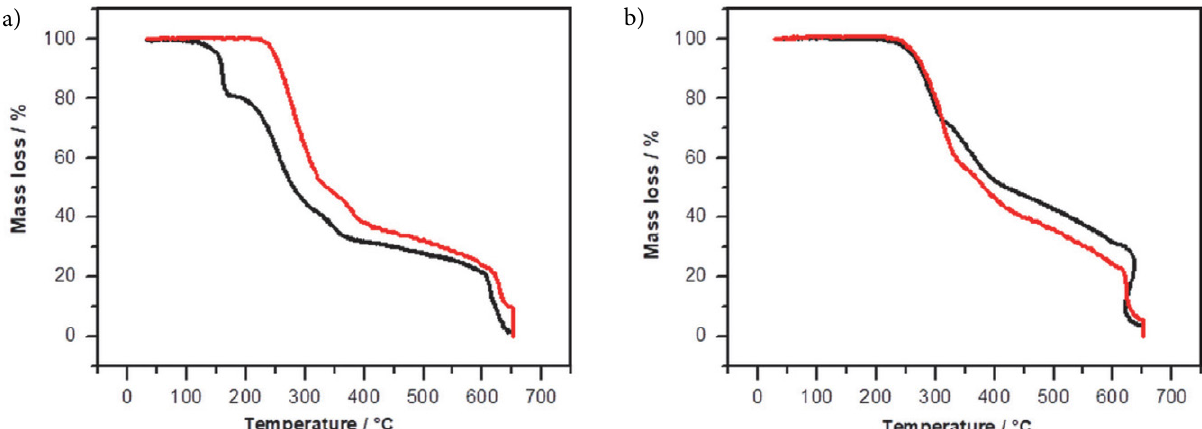
Figure 4. TG curves at different heating rate a. N -(5-chloro-2,4-dinitrophenyl)guanidine ( 2 ), b. N -(5-chloro-2,4-dinitrophenyl)-4-aminopyrazole ( 3 ) [black: 5 °C min –1 , red: 15 °C min –1